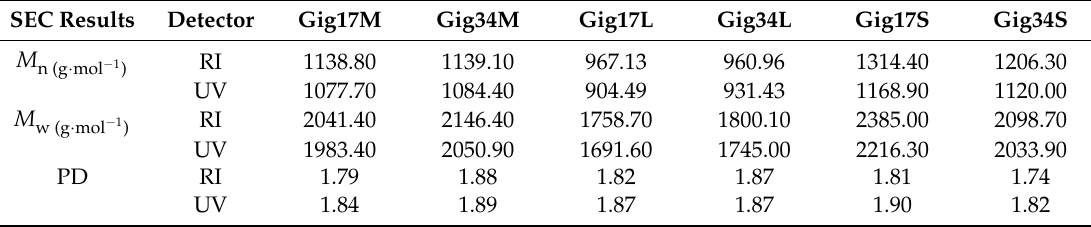
Table 4. SEC results (detected via refractive index (RI) and ultraviolet (UV) detectors) including the number average (Mn) and weight average (Mw) molecular weight and polydispersity (PD) of lignin obtained from Miscanthus x giganteus mixtures (Gig17M, Gig34M), leaves (Gig17L, Gig34L), and stems (Gig17S, Gig34S).